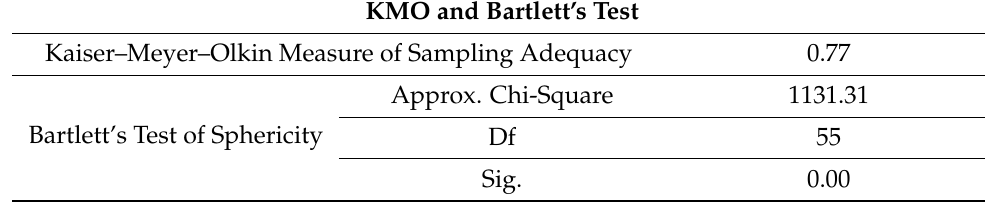
Table 8. Value of the Kaiser–Meyer–Olkin (KMO) measure of sampling adequacy test for verifying the factor analysis veracity.